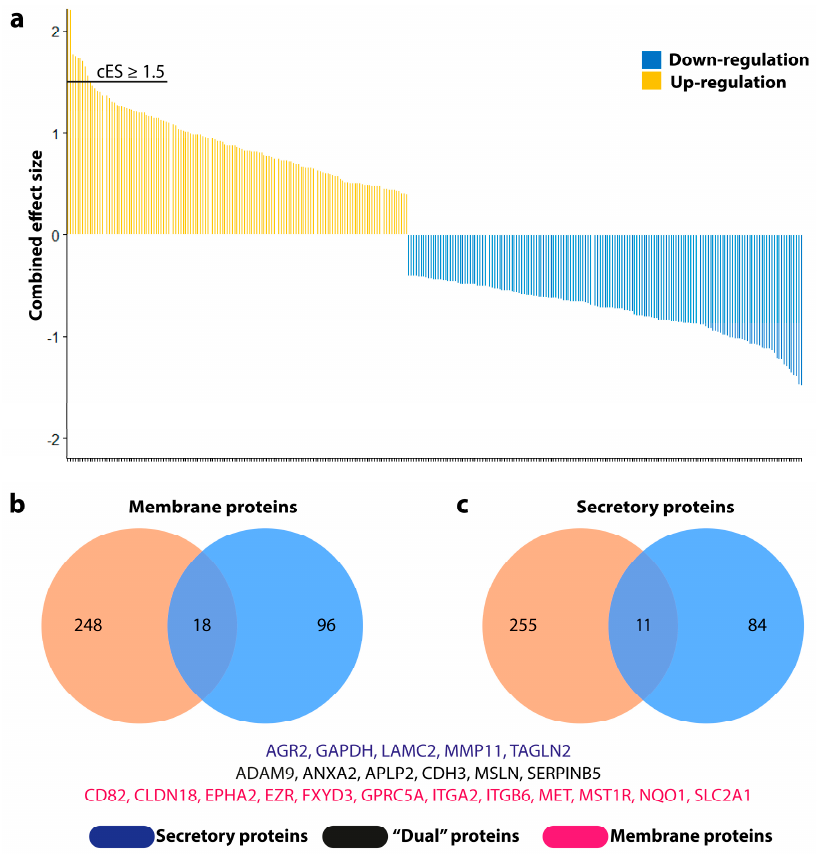
Figure 1. Screening process of innovative biomarker candidates for pancreatic cancer diagnosis and treatment. ( a ) Combined effect size distributions in transcriptome meta-analysis. ( b ) Selection of membrane protein-coding genes. ( c ) Selection of secretory protein-coding genes. The left circle of the Venn diagram (orange) represents the candidates from meta-analysis and the right circle of the Venn diagram (blue) represents the candidates curated from